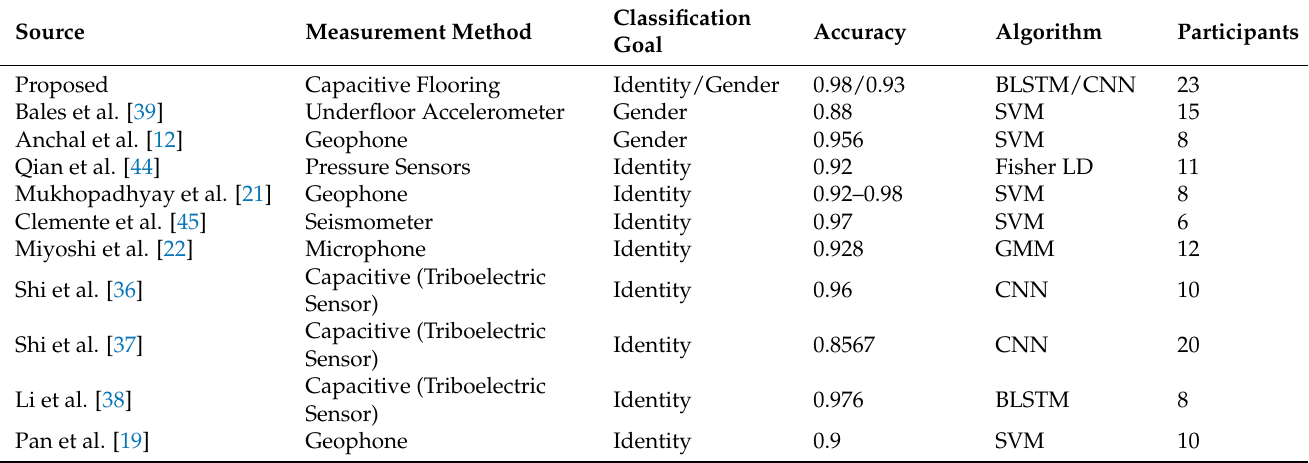
Table 1. Floor-Based Privacy-Preserving Human Classification